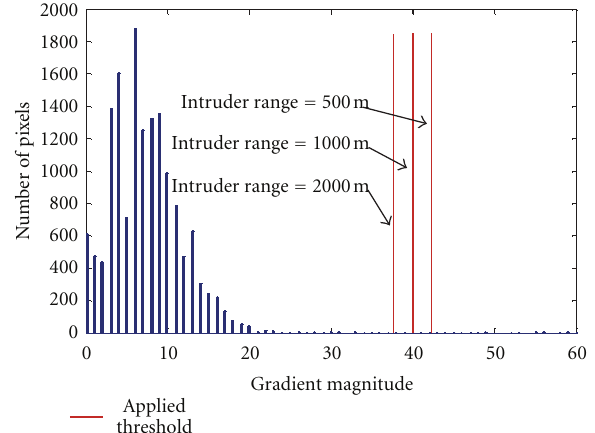
Figure 7: Threshold versus intruder range.